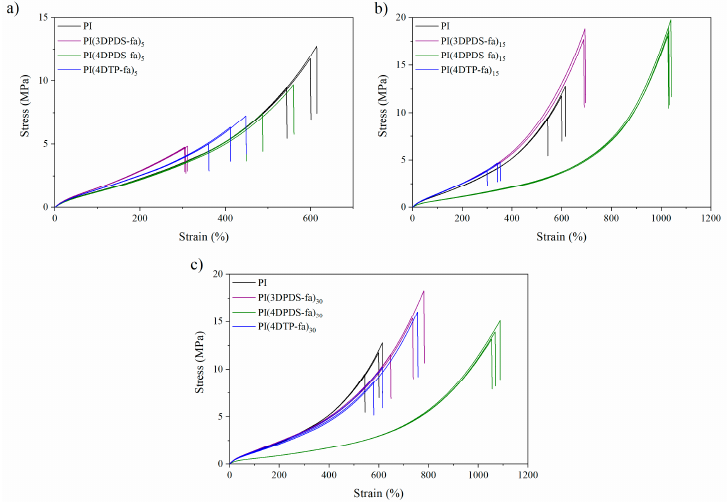
Figure A32. ( a ) Stress-strain curves of the rubber compounds with 5 phr of Bz and the reference; ( b ) Stress-strain curves of the rubber compounds with 15 phr of Bz and the reference; ( c ) Stress-strain curves of the rubber compounds with 30 phr of Bz and the reference.